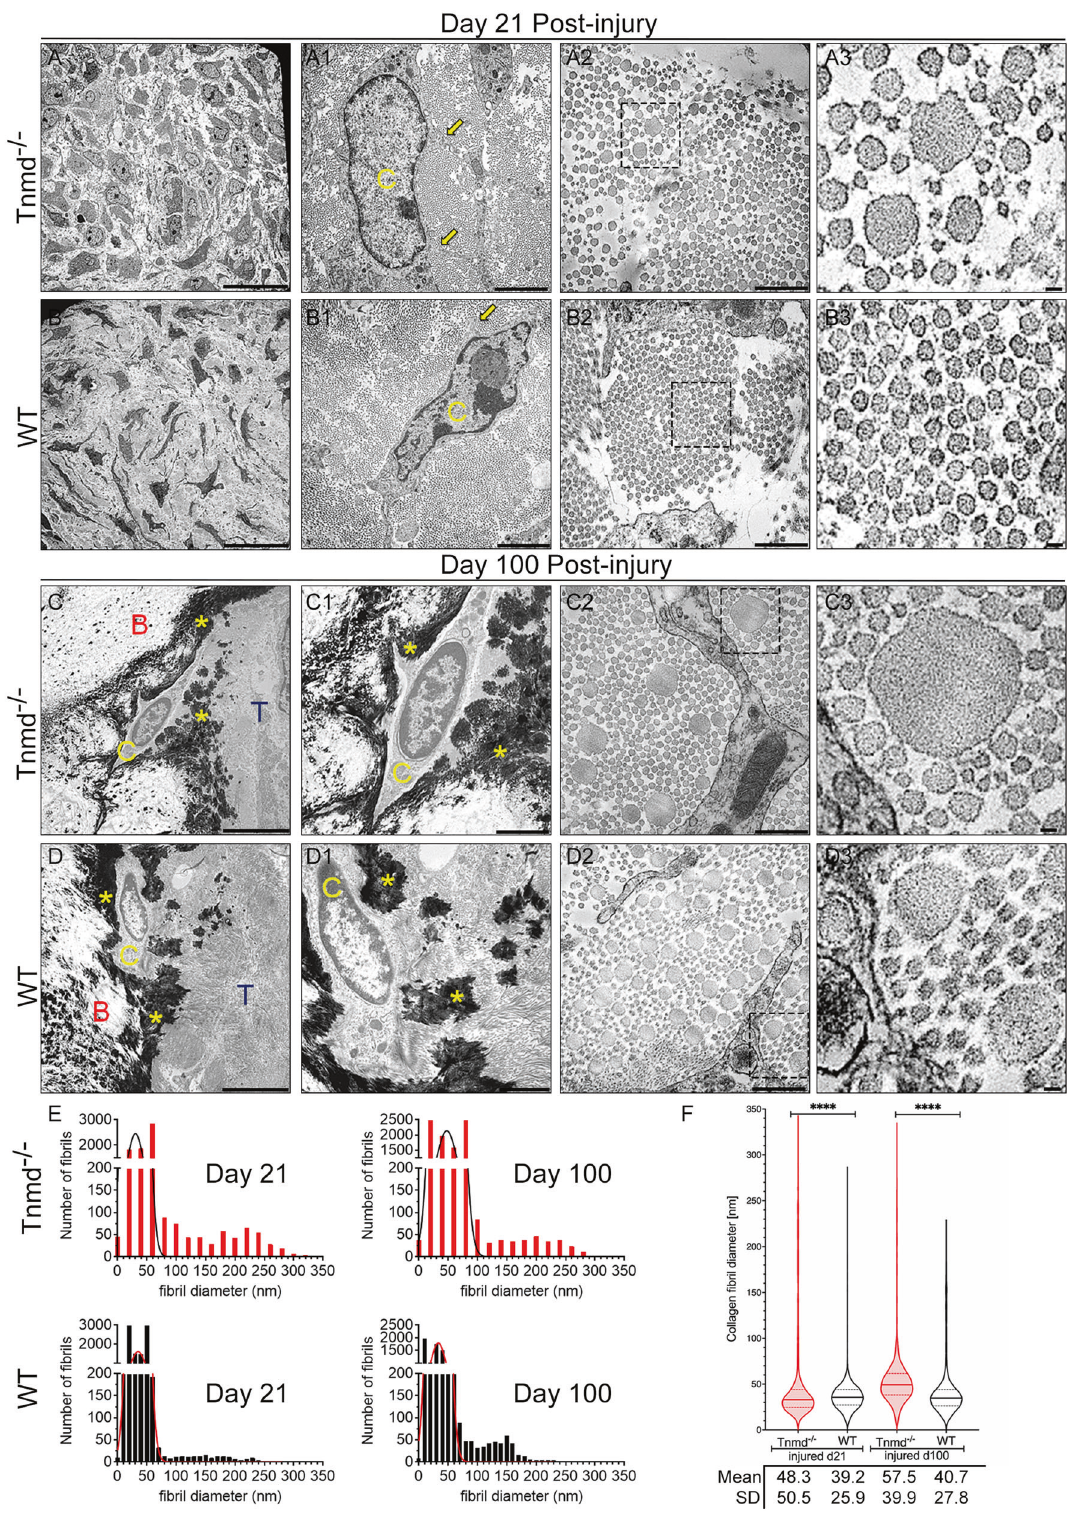
Fig. 3 Transmission electron microscopy and collagen fi bril diameter analysis of Achilles tendons at day 21 and 100 post-injury. A – D Representative 2000x, A1 – D1 10000x and A2 – D3 40,000x magni fi cation images of injured Tnmd − / − and WTAchilles tendons at day 21 and 100 post-injury. C = cell; B = bone; T = tendon; yellow arrow = cell protrusions; yellow asterisk = mineralized zones. Scale bars: 20 µm (panels A , B ); 5 µm (panels C , D ); 2 µm (A1 – D1), 500 nm (panels A2 – D3). E Histograms showing incidence of collagen fi bril sizes. F Violin plot for collagen fi bril diameter distribution, median ± IQR, statistical signi fi cance was calculated by 2-tailed unpaired nonparametric Mann – Whitney test, * p < 0.05, ** p < 0.01, *** p < 0.001, **** p < 0.0001. Day 21, n = 2 animals/genotype; day 100, n = 2 animals/genotype.